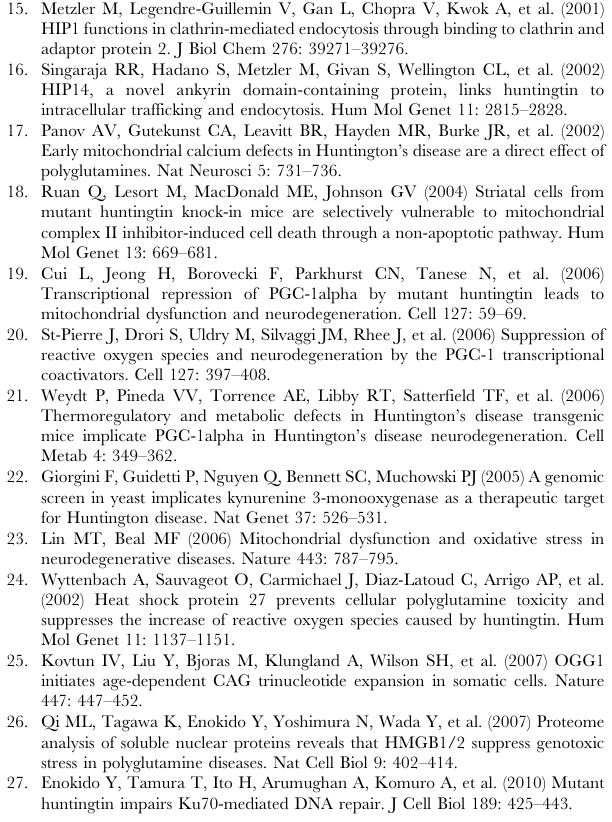
Figure S3 Htt103Q expression was not affected by UAS- Ku70 transgene. To exclude deprivation of GAL4 transcription factor from UAS-Htt103Q by UAS-Ku70 underlies amelioration of the phenotype, we performed RT-PCR to test expression level